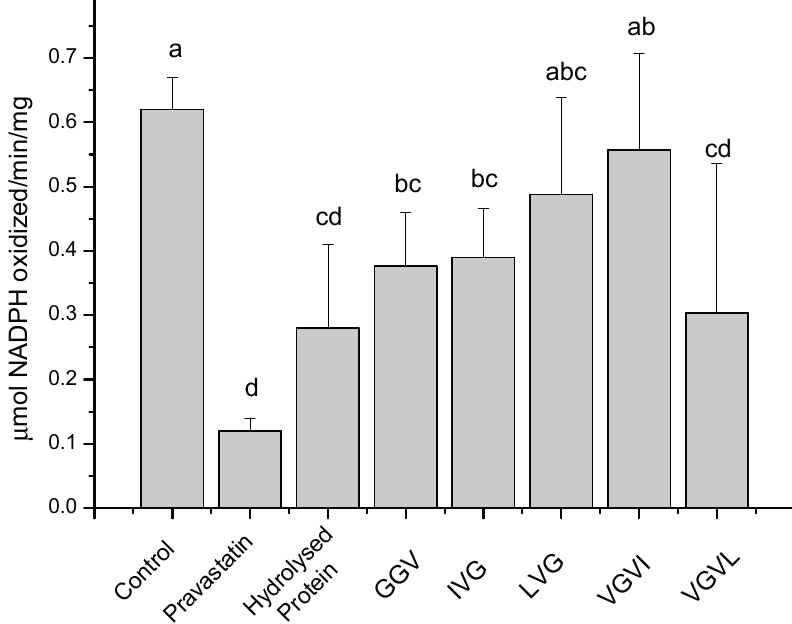
Figure 3. Evaluation of HMG-CoA reductase activity in control (absence of peptides or drugs), in positive control (in the presence of pravastatin), in hydrolyzed amaranth protein filtered through a 3 KDa M w cut off membrane, and in added of each peptide. Different letters mean significant differences among samples ( p <